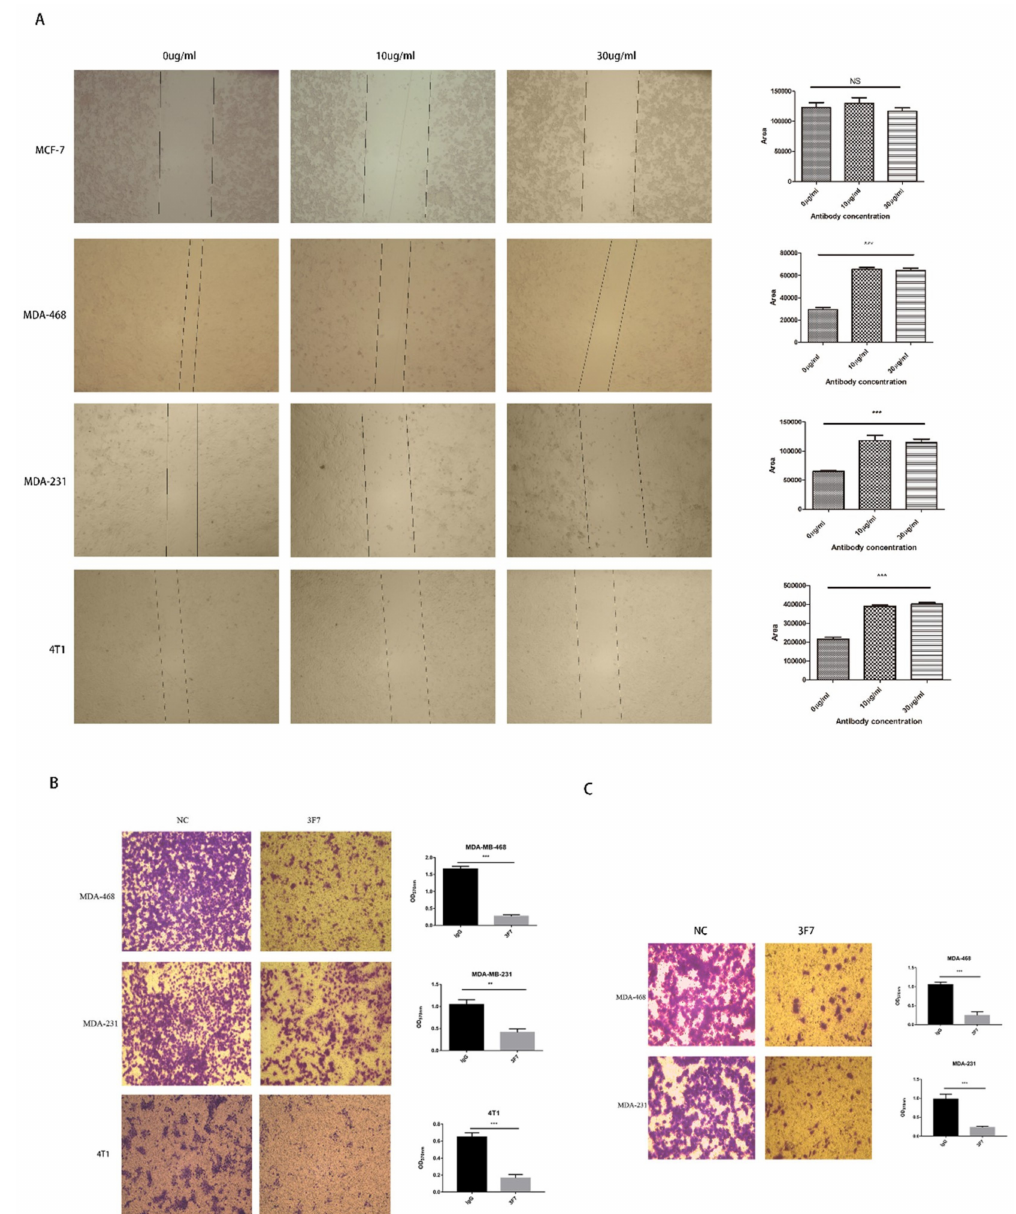
Figure 6. The analysis of the migration and invasion of cells treated with the anti-CD73 antibody: ( A ) the wound healing assay showed that different concentrations of 3F7 mAb inhibited the cell migration (40 × ) and ( B , C ) the Transwell assays showed that 3F7 (10 µ g/mL) inhibited the migration and invasion of cells (40 × ), respectively. Data were shown as means ± SD and analyzed by two tailed t -test; NS, not significant; ** p < 0.01; *** p < 0.001. Data were representative of at least three independent